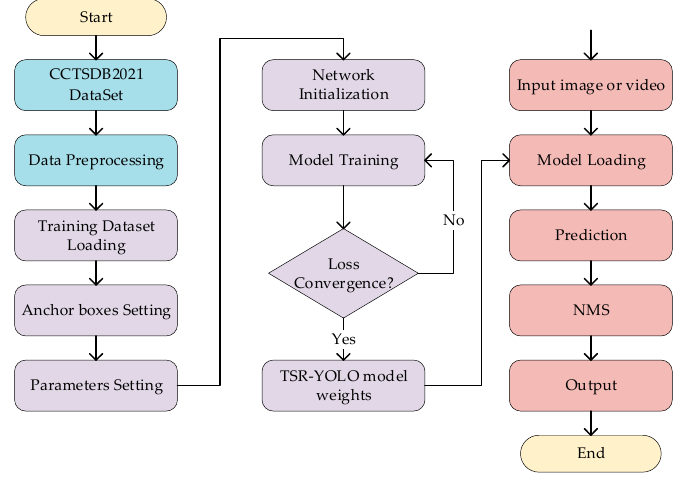
Figure 10. The traffic detection process based on TSR-YOLO.